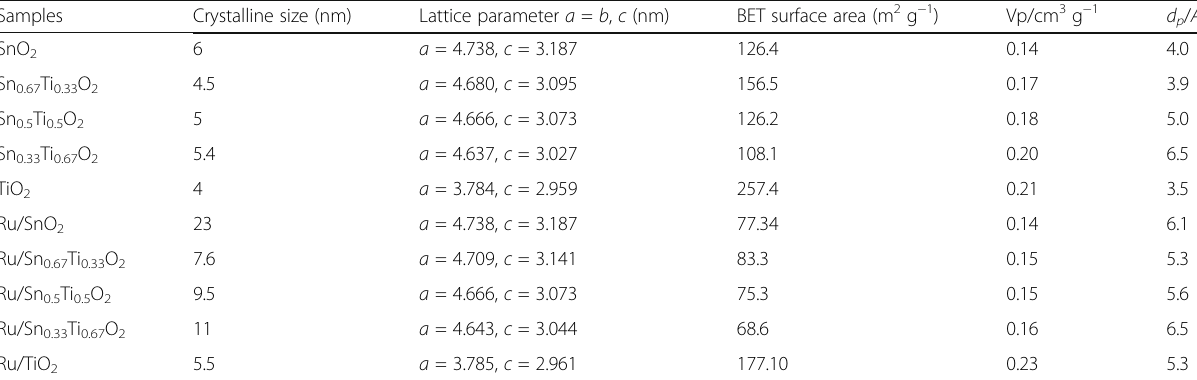
Table 1 Texture properties of Sn x Ti 1 − x O 2 supports and Ru/Sn x Ti 1 − x O 2 catalysts